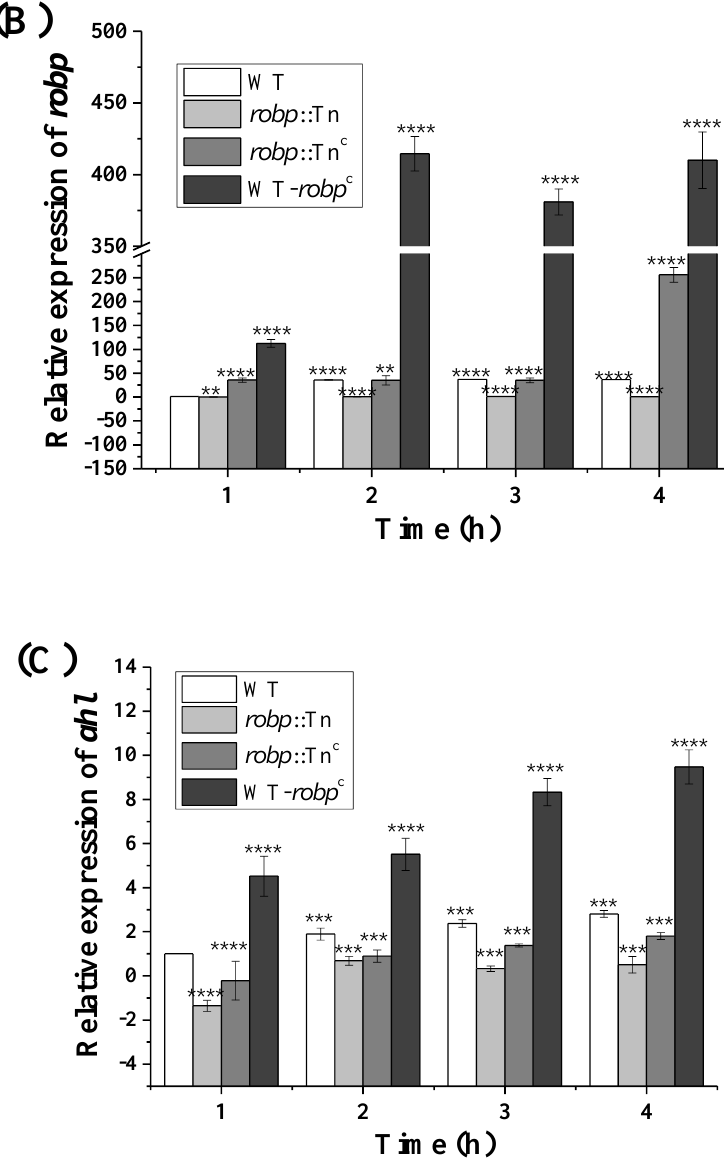
Figure 3. Growth profile and QS-related phenotype in wild-type, mutant, complicon and overexpressor. ( A ) Growth and QS-based colorization of biosensor A136; ( B ) Relative expression level of robp gene encoding right origin-binding protein; ( C ) Relative expression level of ahl gene encoding acyl homoserine lactone synthase. WT: wild-type (strain T1lg65); robp ::Tn: mutant of strain T1lg65 with disrupted robp gene by Tn 10 ; robp ::Tn c : complon of robp ::Tn with complementation of robp ; WT+ robp c : overexpressor of strain T1lg65 with overexpression of robp . All independent experiments were repeated in triplicate. Significant difference is respectively indicated by asterisks as follows: *** p < 0.001; **** p < 0.0001. Gene expression in WT at 1h was treated as 1 (internal reference).